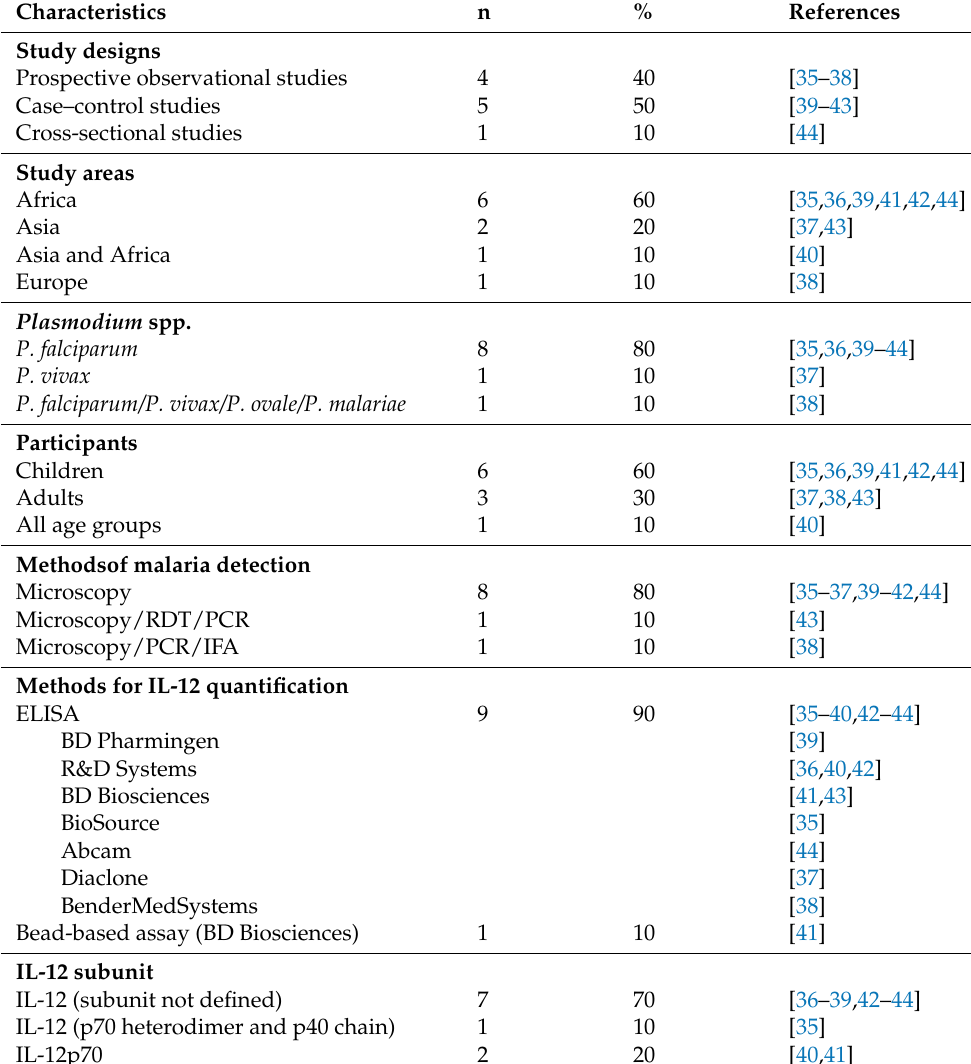
Table 1. Characteristics of the included